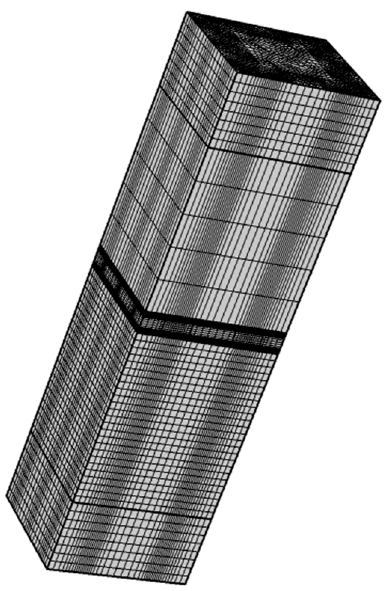
Figure 8. The meshing diagram of the finite element model.